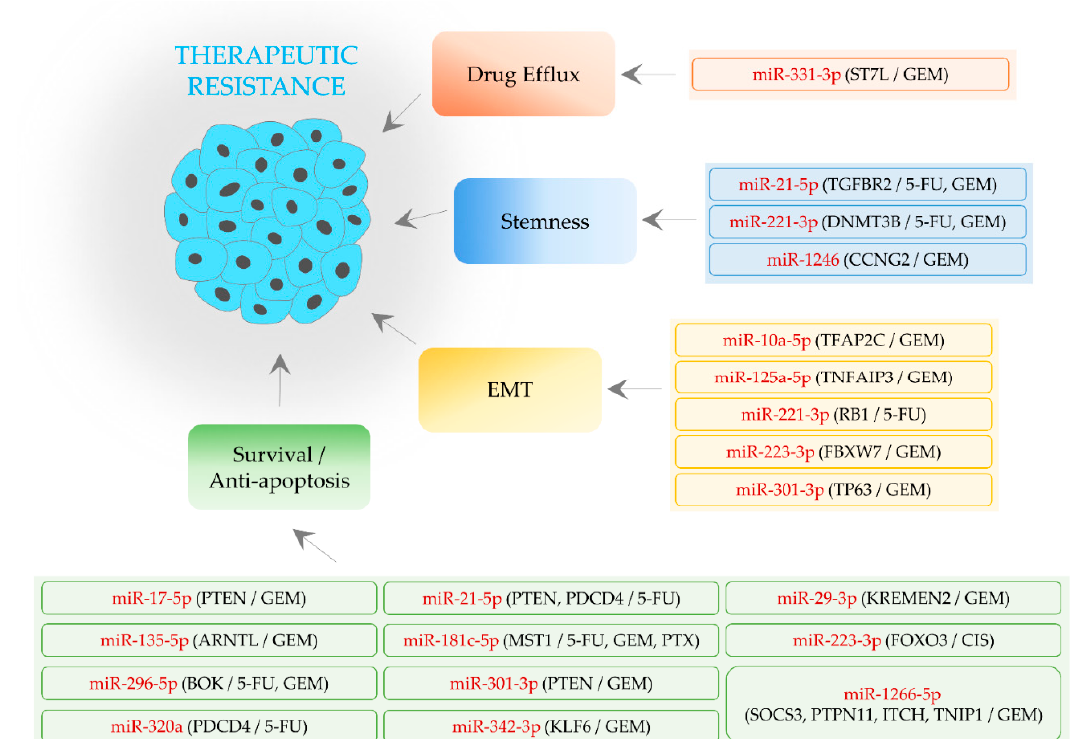
Figure 1. MiRNA-mediated aggravation of therapeutic resistance in pancreatic cancer (PaC). Oncogenic miRNAs in rounded rectangles are shown in red. Round brackets denote target genes of miRNAs and then therapeutic agents affected by miRNAs. Activation is indicated by an arrow. GEM: gemcitabine; 5-FU: 5-fluorouracil; PTX: paclitaxel; CIS: cisplatin. Table 1. Oncogenic miRNAs that reinforce therapeutic resistance in PaC. Ref. miRNA Expression